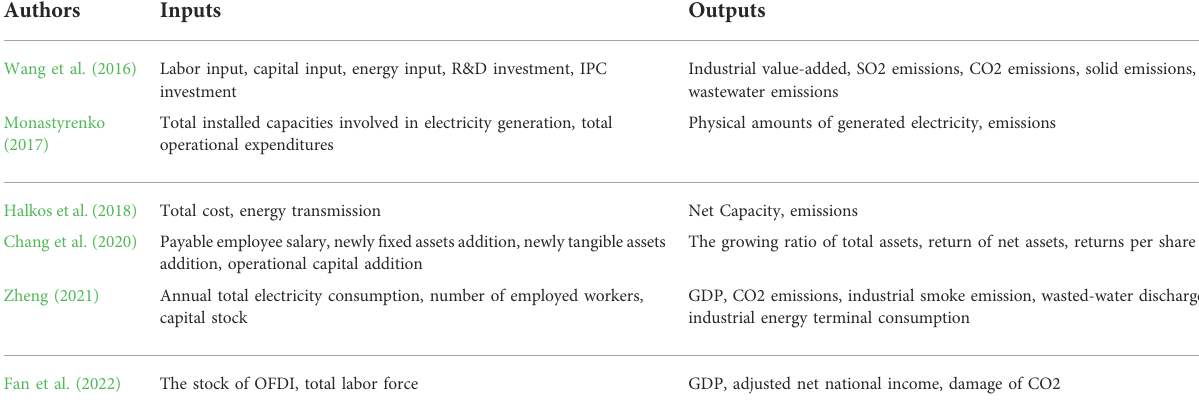
TABLE 1 A summary of evaluation indexes of investment merger ef fi ciency of electricity companies. Authors Inputs